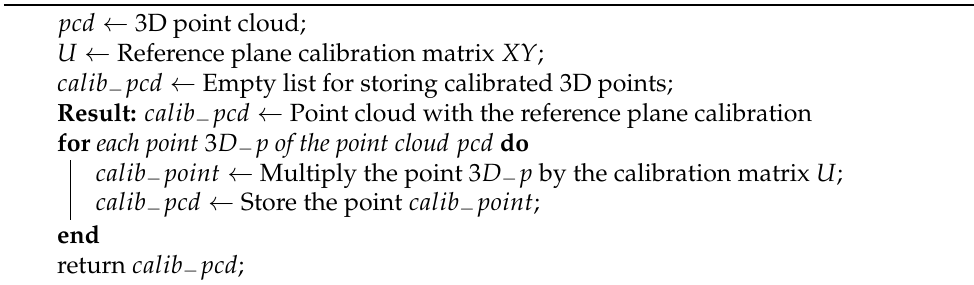
Algorithm 5: Algorithm for calibrating the reference plane XY of point